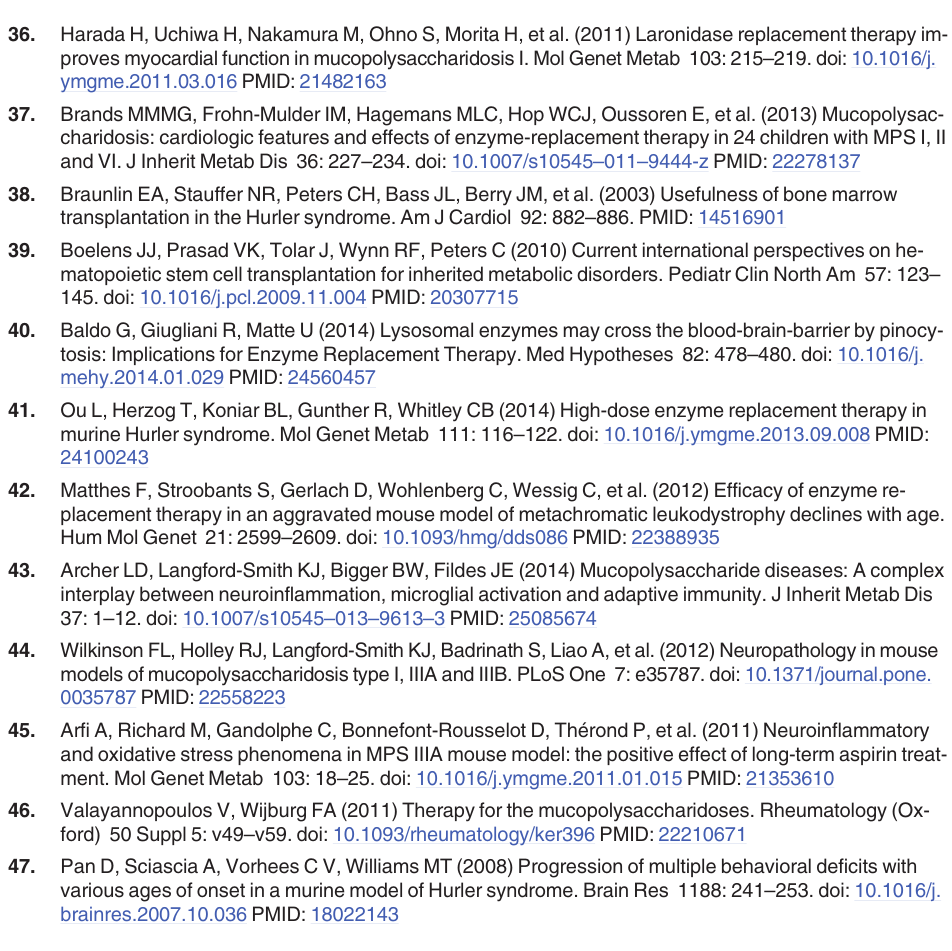
PLOS ONE | DOI:10.1371/journal.pone.0117271 February 3,